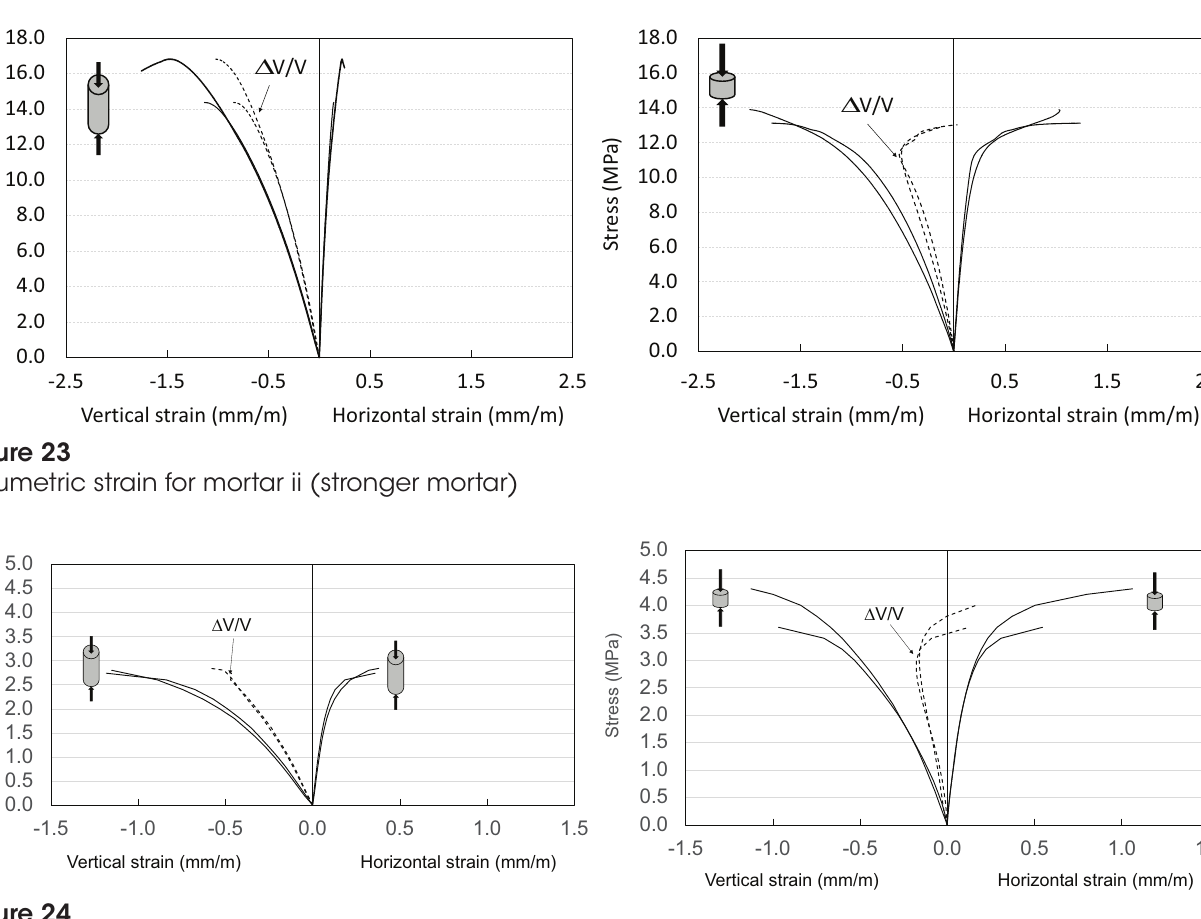
Volumetric strain for mortar iii (weaker